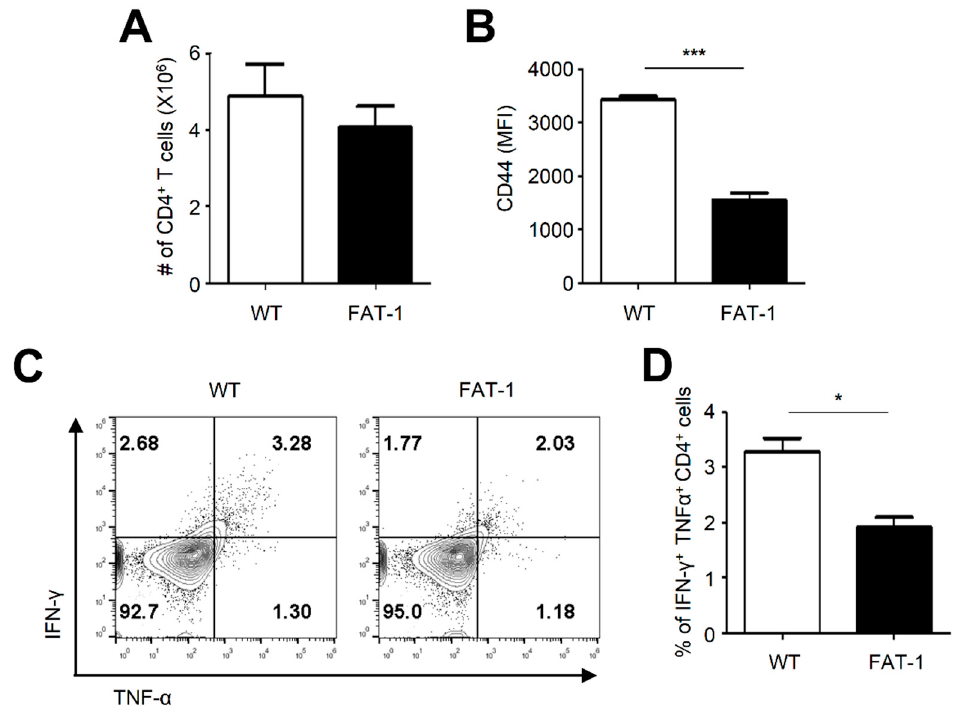
Figure 5. Anti-viral CD4 + T cell responses are diminished in FAT-1 mice. WT and FAT-1 mice were infected with LCMV (Armstrong) for 7 days. ( A ) The numbers of CD3 + / CD4 + T cells harvested from spleens are shown. ( B ) The surface expression of CD44 on CD4 + T cells of WT and Fat-1 splenocytes was analyzed using flow cytometry. ( C , D ) Splenocytes were incubated with µ g / mL of LCMV GP61 peptide for 5 h, and intracellular staining for IFN- γ and TNF- α was performed. The representative flow cytometry plots were shown ( C ). The percentage of IFN- γ + TNF- α + CD4 + T cells was analyzed using flow cytometry ( D ). The data represent the mean ± SEM ( n = 4 mice per group). * p ≤ 0.05; *** p ≤ 0.001. The data represent the results of at least three independent experiments.